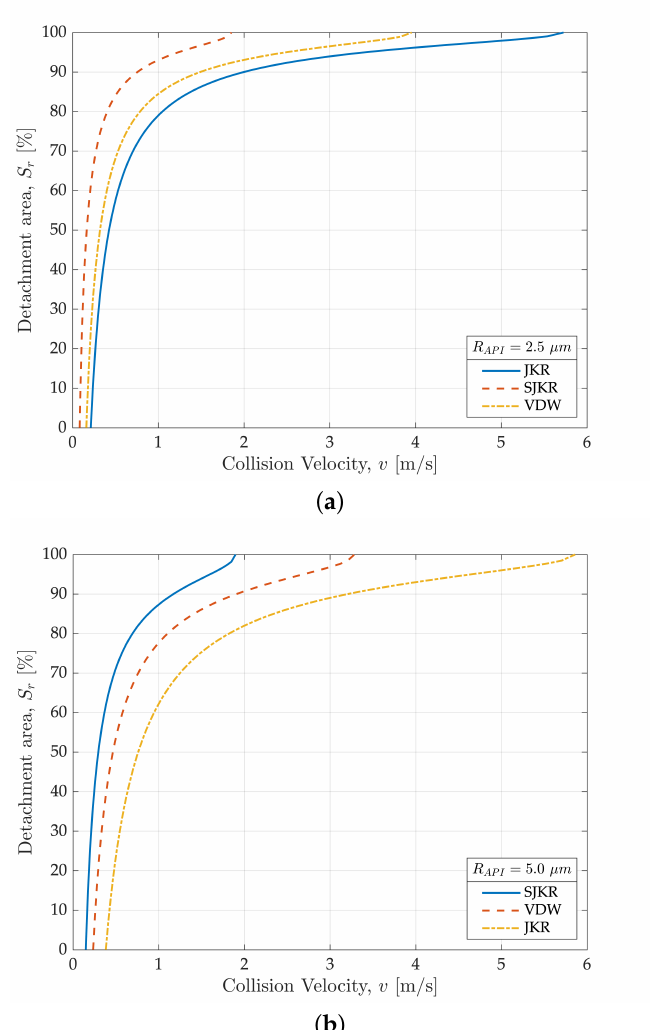
Figure A4. Fraction of uncovered surface vs. collision velocity. R API = 2.5 µ m ( a ) or 5.0 µ m ( b ); R C = 50 µ m; Bo =